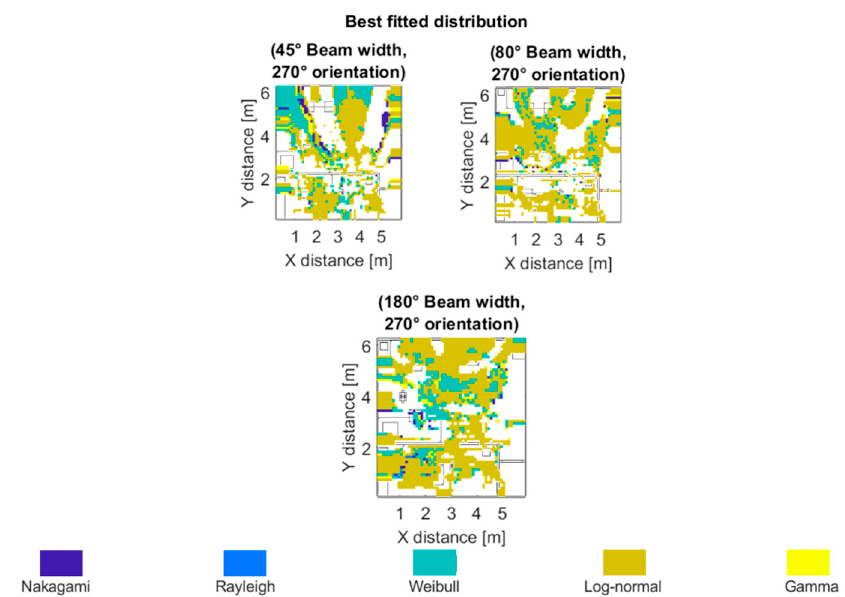
Figure 15. Best fitted distribution for the indoor scenario.